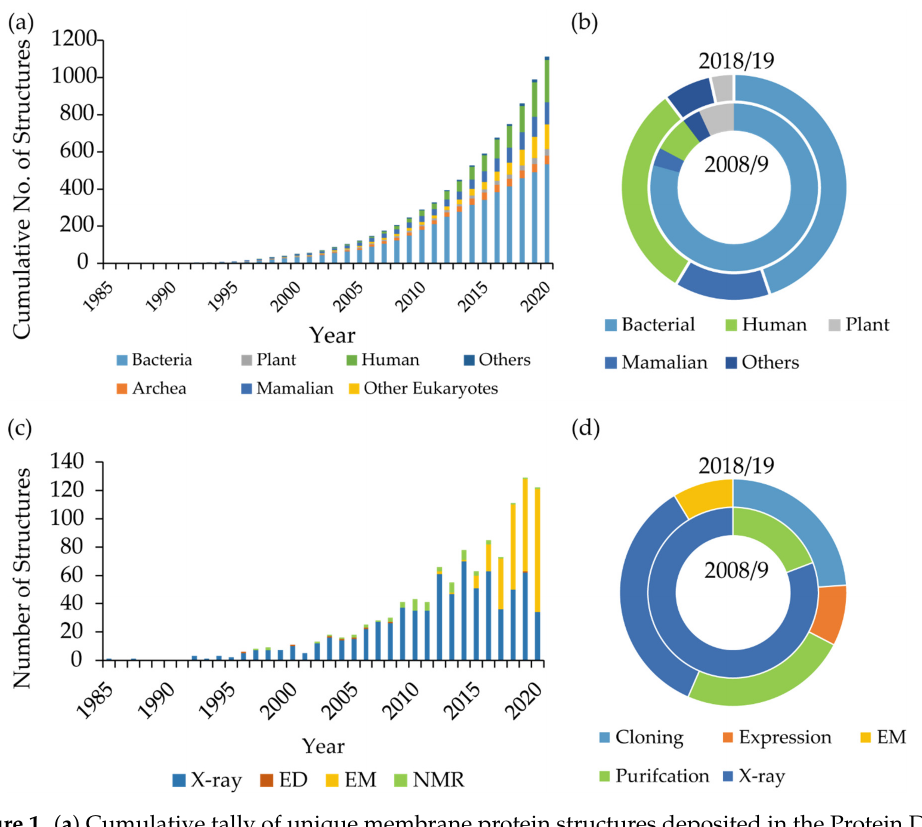
Figure 1. ( a ) Cumulative tally of unique membrane protein structures deposited in the Protein Data Bank (PDB) adapted from the Membrane Proteins of Known 3D Structure database [4]. ( b ) Membrane Protein Laboratory (MPL) projects classified by target origin in 2008/9 (29 projects) and 2018/19 (46 projects). ( c ) Number of membrane protein structures solved each year by electron diffraction (ED), electron microscopy (EM), X-ray crystallography and nuclear magnetic resonance spectroscopy (NMR) ( d ) accepted MPL projects by requested technology platform in 2008/9 (29 projects) and 2018/19 (46 projects). Cloning and expression were not supported in 2008/9. Table 1. Membrane protein (MP) structures that have been supported by the work of MPL researchers.